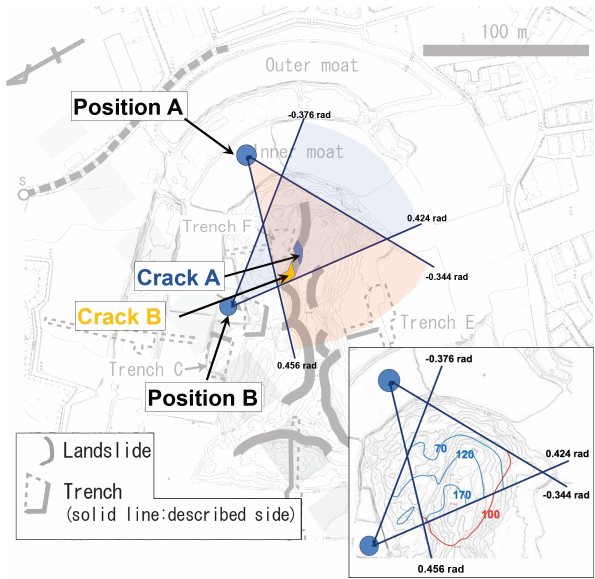
Figure 1. Top view of the Imashirozuka burial mound. Positions A and B indicate the locations of the detectors for the current bidirec- tional muographic observations. The shaded areas in red and blue indicate the viewing angle of each measurement. The inset shows the geometrical information of the mound. The red and blue solid curves respectively indicate the cross sections of the mound at given elevation angles from positions A and B. The red and blue numbers indicate the elevation angles in milliradian